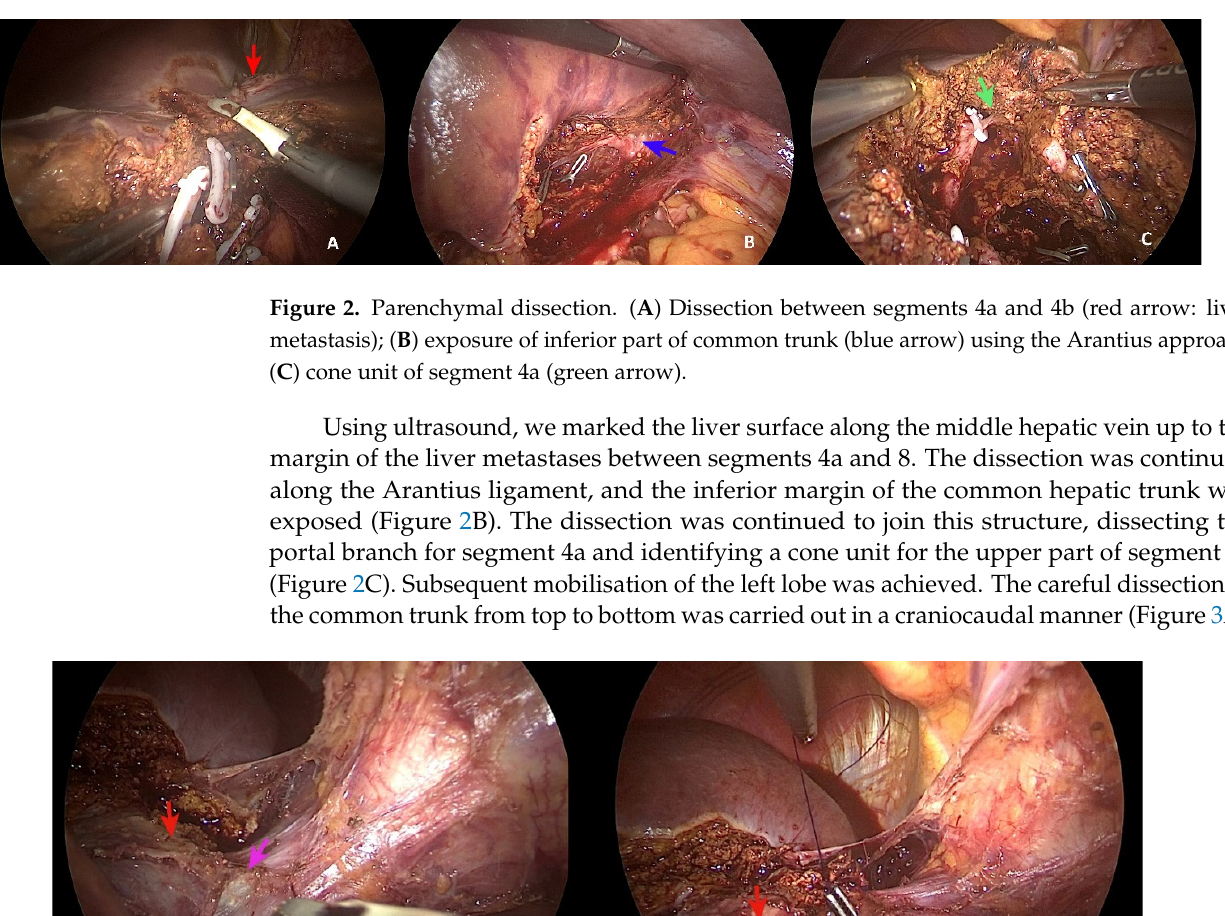
Figure 4. Exposure of the middle hepatic vein. ( A ) Insertion of the linear stapler from the bottom section of the left hepatic vein (blue arrow: left hepatic vein); ( B ) exposure of the middle hepatic vein after section of the left hepatic vein (blue arrow: left hepatic vein; violet arrow: middle hepatic vein; red arrow: liver metastasis).